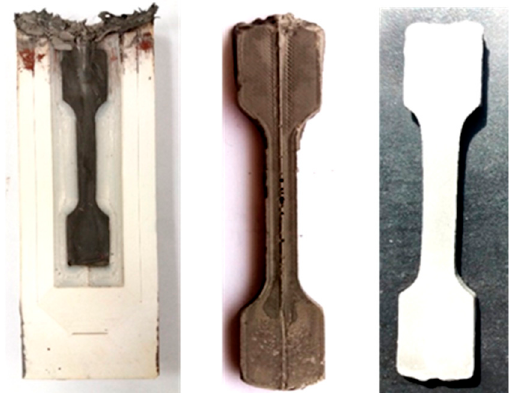
Figure 11. Nylon split mold with green and sintered MIM parts.